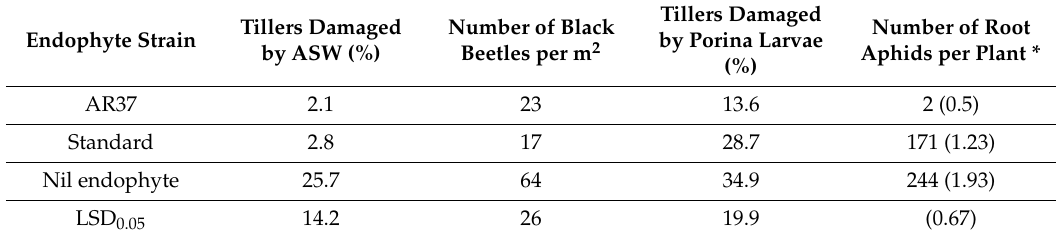
Table 7. The e ff ect of AR37 endophyte strain in perennial ryegrass on insect pests. (Taken from [260]). Endophyte Strain